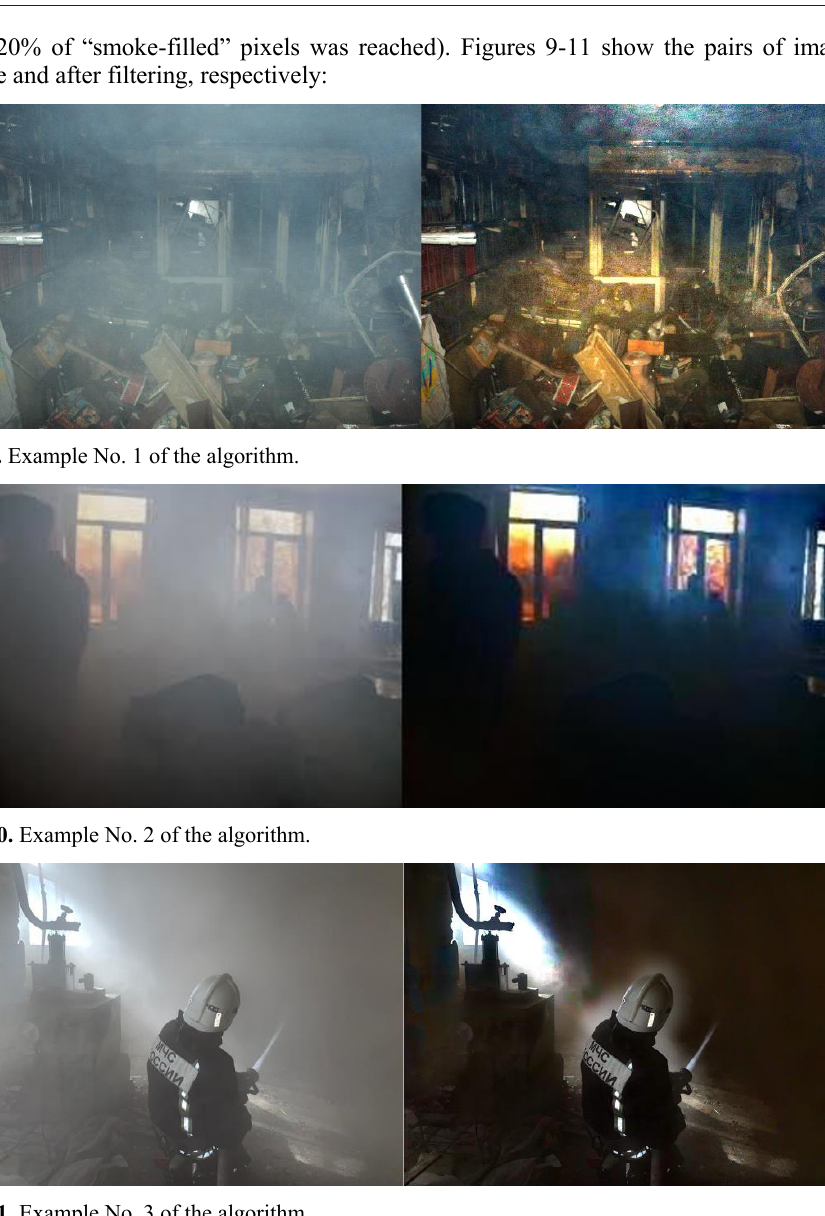
Fig. 11. Example No. 3 of the